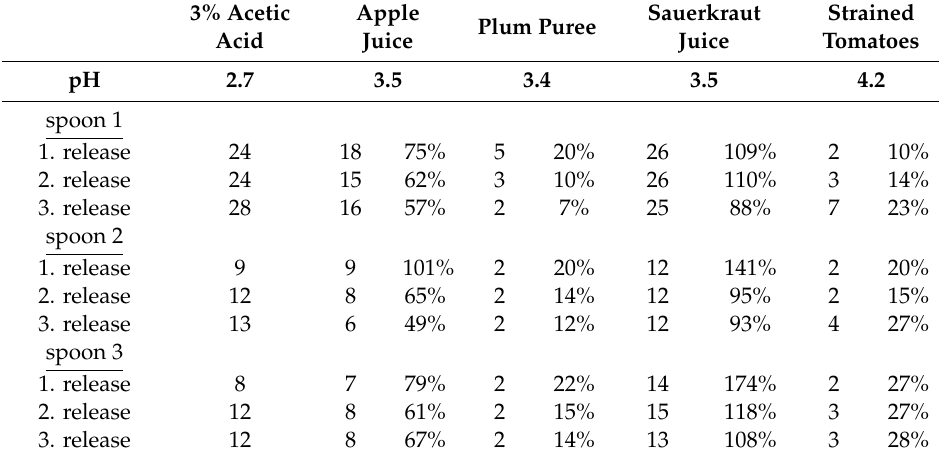
Table 2. Release of formaldehyde (mg / dm 2 ) into acidic foods in hot plate conditions (2 h@100 ◦ C) and the ratio (%) of that release compared to 3% acetic